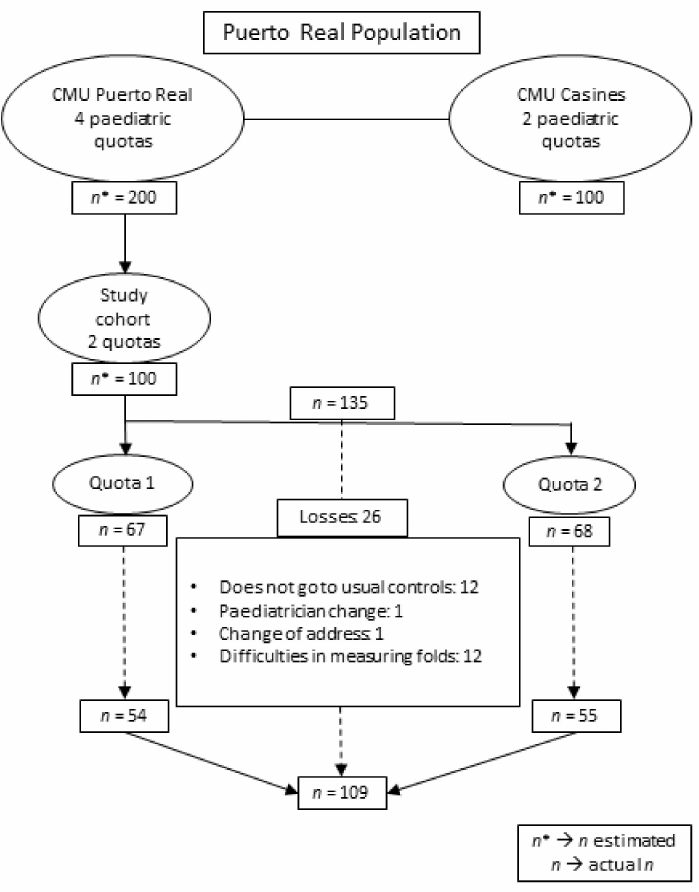
Figure 1. Characteristics of the study population ( n = 109) . n * is referred to the initial estimation of n